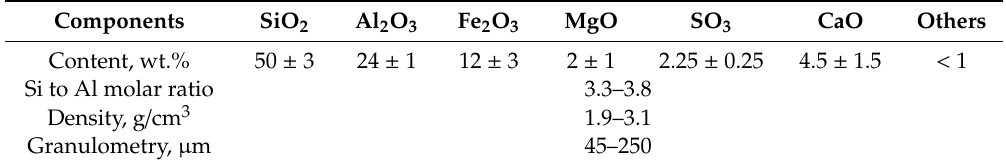
Table 1. Variation in the chemical composition and some physicochemical properties of lignite coal fly ash (FA) sampled from di ff erent Thermal Power Plants (TPPs).